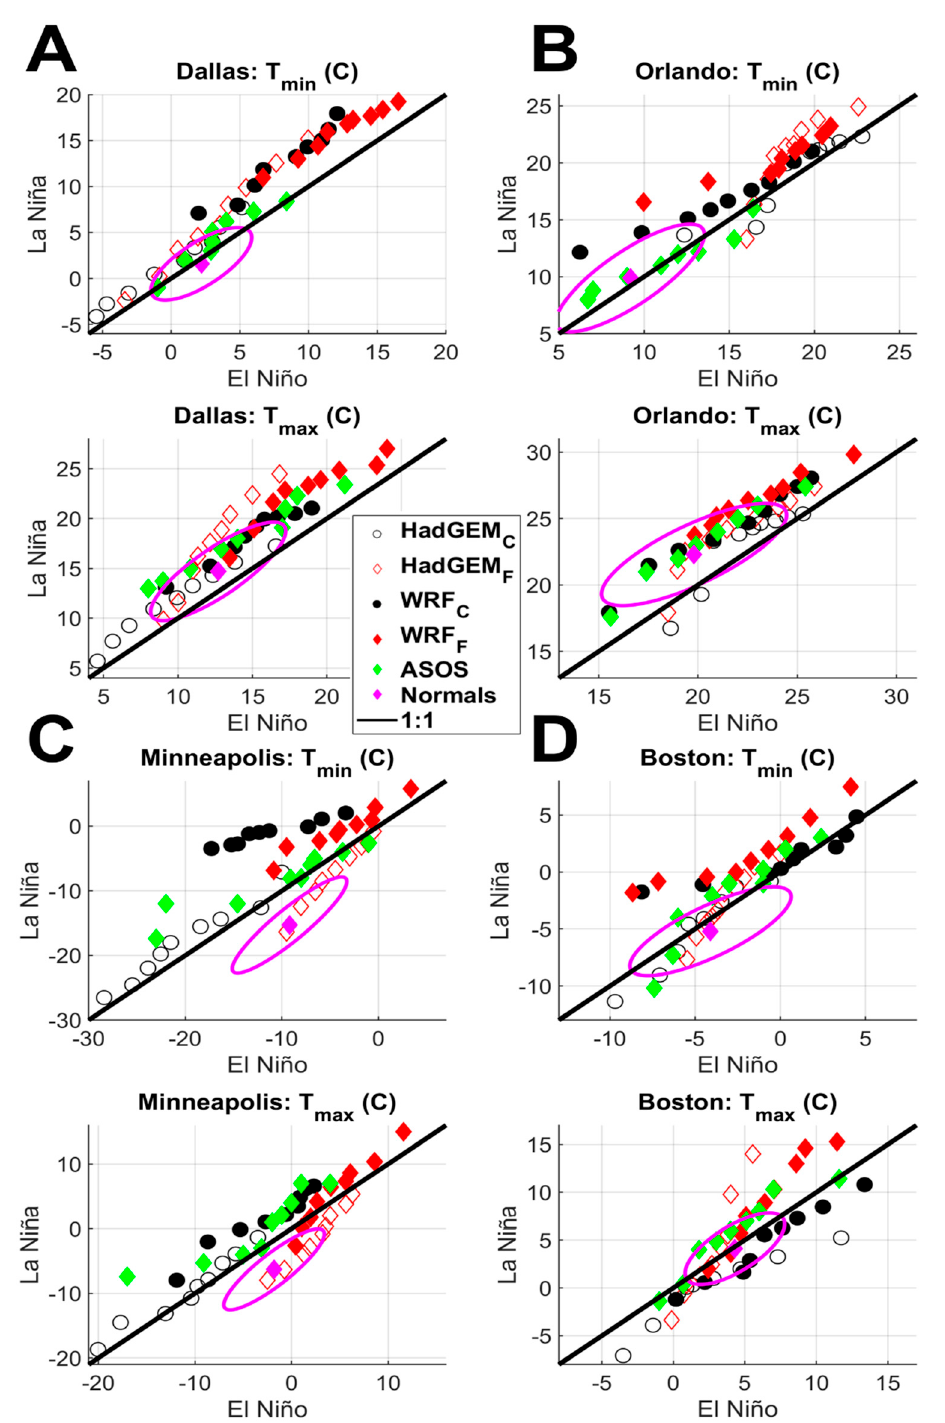
Figure 9. Empirical quantile–quantile plots (10th to 90th percentiles) of January Tmin and Tmax as a function of ENSO phase from HadGEM2 and HadGEM2-WRF for selected cities: ( A ) Dallas; ( B ) Orlando; ( C ) Minneapolis; ( D ) Boston. The black circles are for the historical climate and the red diamonds are for the future climate (open symbols for HadGEM2, solid for HadGEM2-WRF). ASOS observations for January 1985 (El Niño) and January 2000 (La Niña) are shown in green, the mean values for strong El Niño and weak La Niña conditions are shown by the magenta symbol, with the range shown by the ellipse [10]. The black line indicates the 1:1 slope. The points above the black line mean the La Niña days are warmer than the El Niño days.